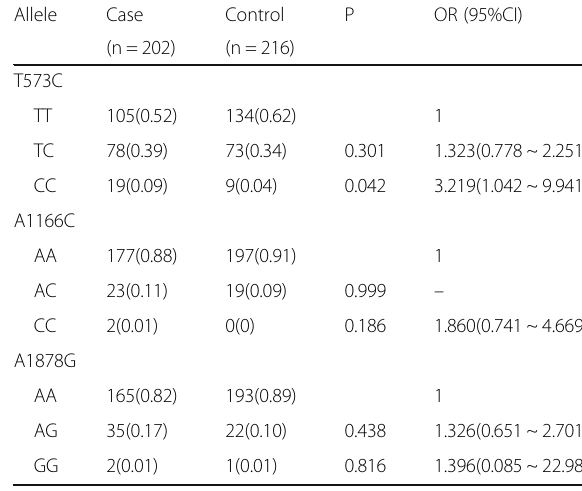
Table 6 Analysis of the association between rs5182, rs5186